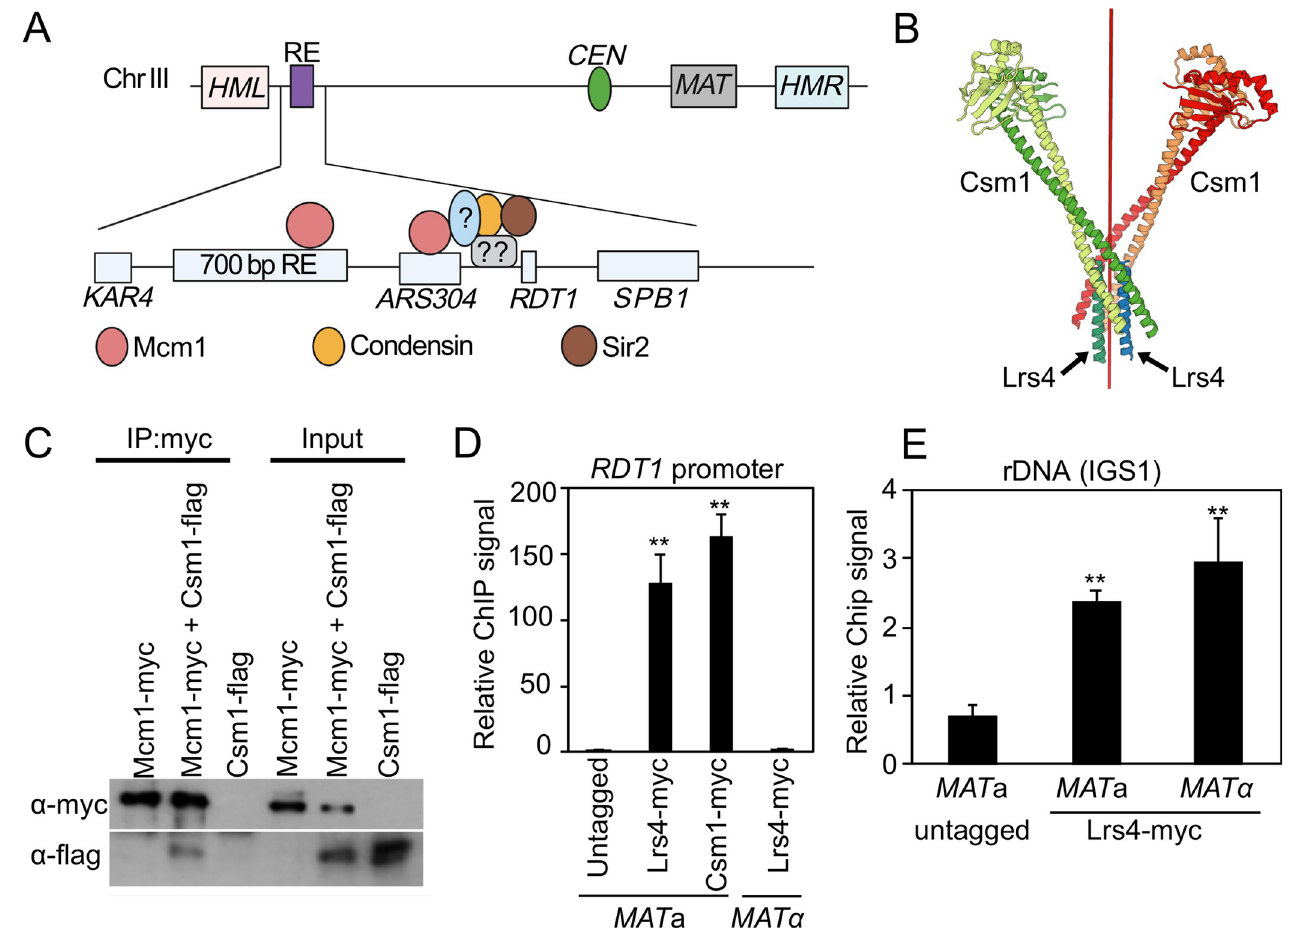
Fig 1. Cohibin binds to the RDT1 promoter on chrIII specifically in MAT a cells. ( A ) Schematic of chrIII in MAT a cells. The recombination enhancer (RE) region lies between KAR4 and SPB1 and consists of a minimal 700 bp element required for donor preference, two Mcm1/ α 2 binding sites, ARS304 , and a Sir2/ condensin recruitment site within the RDT1 promoter. Uncharacterized factors are proposed to assist Sir2 and condensin recruitment by Mcm1. ( B ) X-ray crystallographic structure of cohibin consisting of 4 Csm1 subunits and 2 short Lrs4 subunit peptides, showing extended coiled-coil feature. Red line indicates the axis of symmetry. PDB accession number 3N7N [26]. ( C ) Immunoblot showing that Mcm1-myc coimmunoprecipitates with Csm1-flag. Loaded inputs are 5% of cell lysate used for the IP. ( D-E ) Enrichment of Lrs4-myc and Csm1-myc at the RDT1 promoter or IGS1 regions of the rDNA. (Three biological replicates; ** p < 0.005 relative to untagged strain determined by two-sided t-test assuming unequal